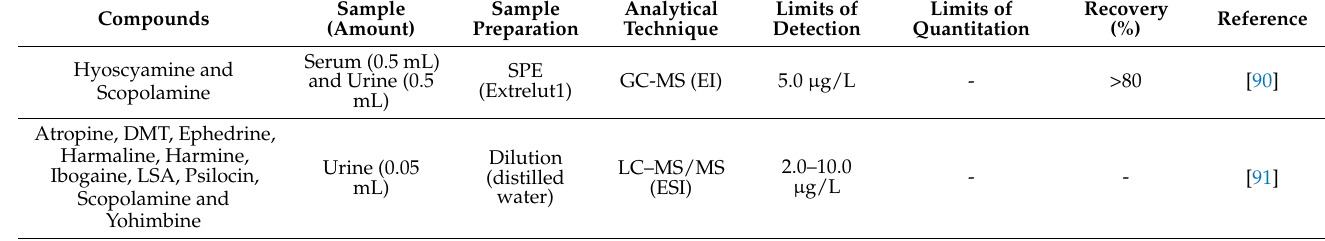
Table 4. Analytical methods for the determination of the main components of Datura stramonium and Mandragora officinarum . Compounds Sample (Amount) Sample Preparation Analytical Technique Limits of Detection Limits of Quantitation Serum (0.5 mL) Hyoscyamine and and Urine Scopolamine